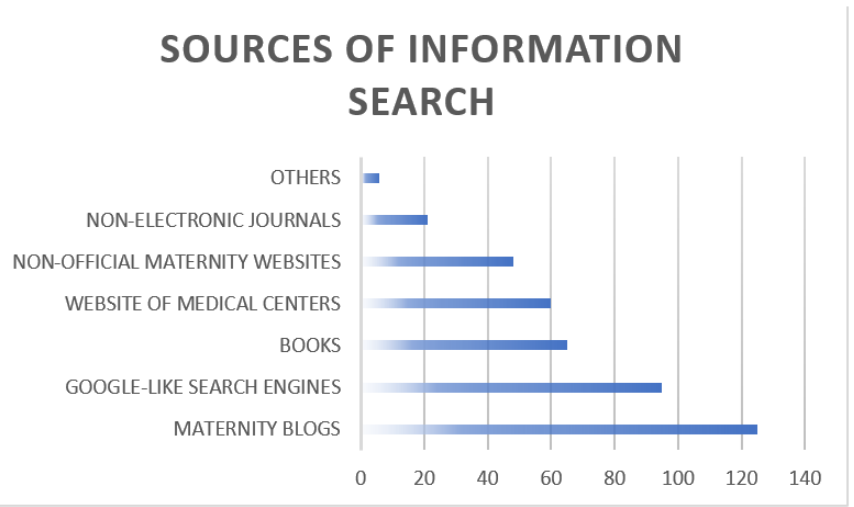
Figure 1. Sources of information search: preferred Internet search sites for pregnant women. A total of 93.9% (185/197) preferred the direct sending of information in newsletter format compared to 6.1% (12/197) who preferred to consult it by means of an autonomous search. 73.1% (144/179) shared information with their